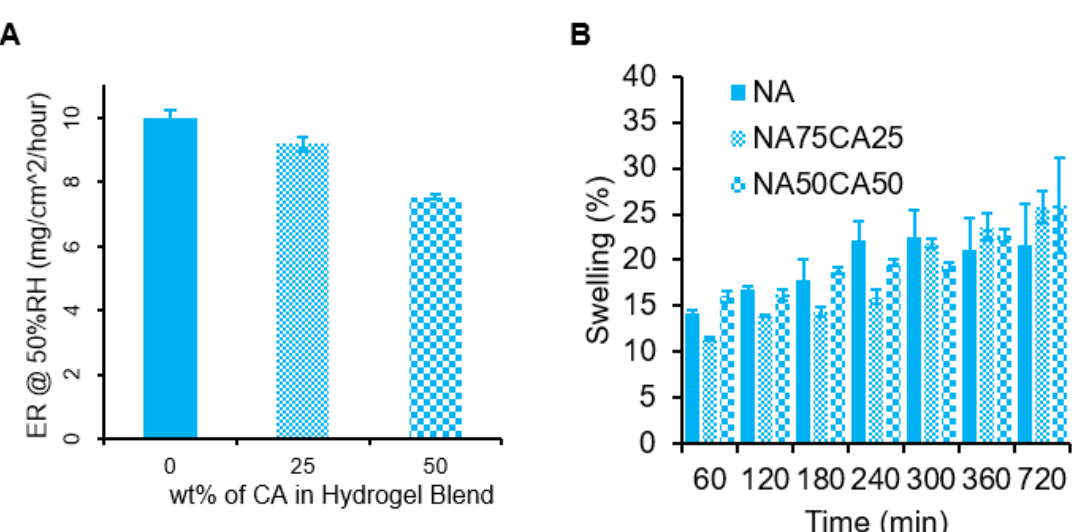
Figure 3. ( A ) Rate of water evaporation (ER) from 3 mm thick hydrogel blends for 12 h at 50% humidity, with measurements taken every 10 min. The results are normalized and have units of mg / cm 2 / hour. Error bars show standard error for n = 5. ( B ) Hydrogel swelling for each formulation measured over 12 h.